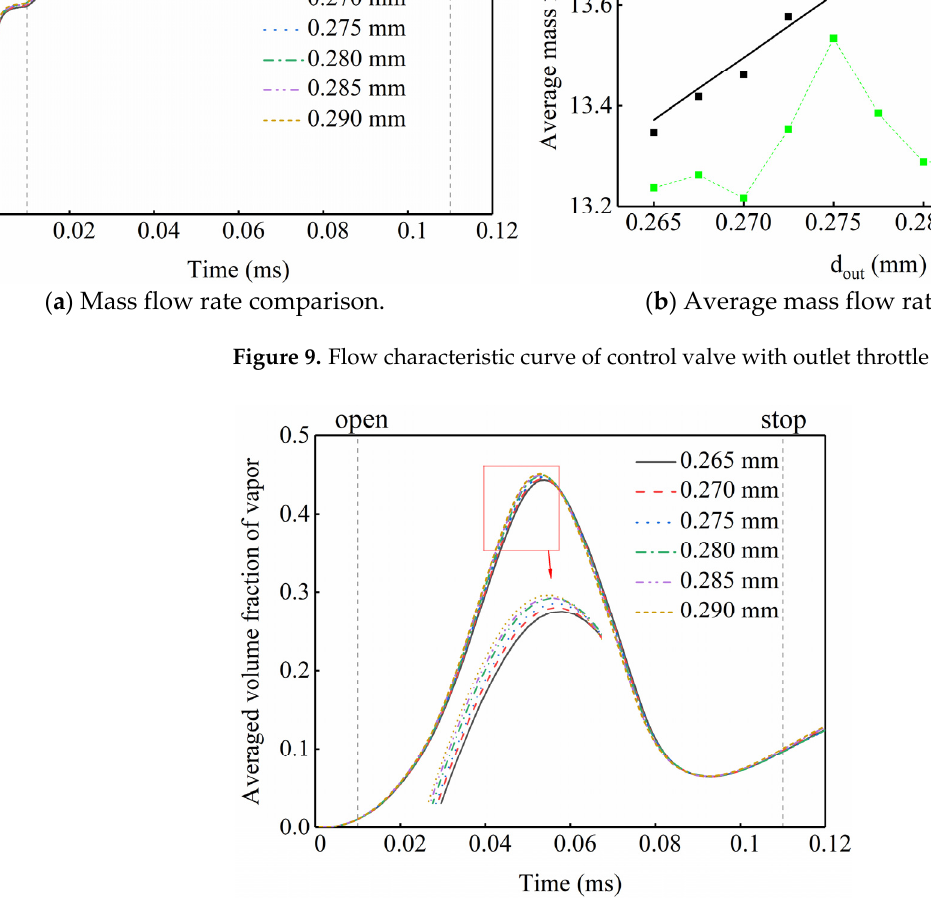
Figure 10. Effect of the outlet throttle diameter deviation on the average vapor volume fraction. Q out